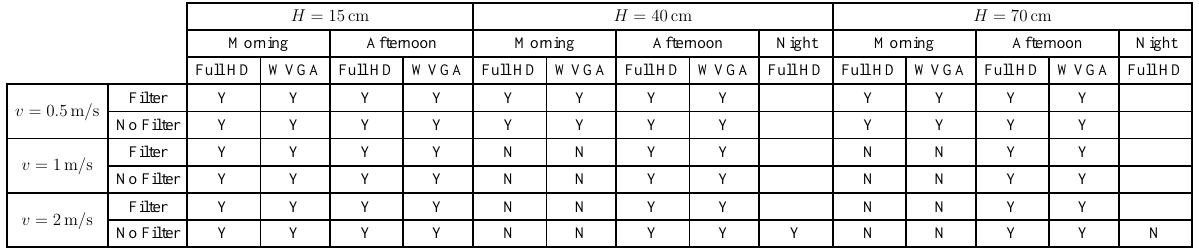
Figure 5. ( a ) Time series of the index G for a successful experiment; ( b ) time series of the index G for a failed experiment; and ( c ) frames depicting the entrance, transit, and exit, respectively, of the particles in the region of interest for the successful experiment in